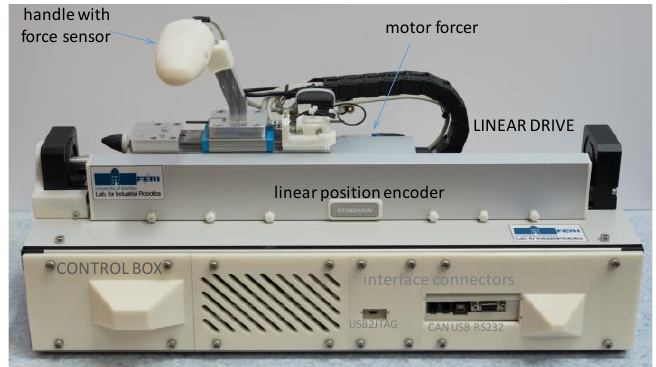
Figure 10. The photo of the experimental haptic interface for power lever.